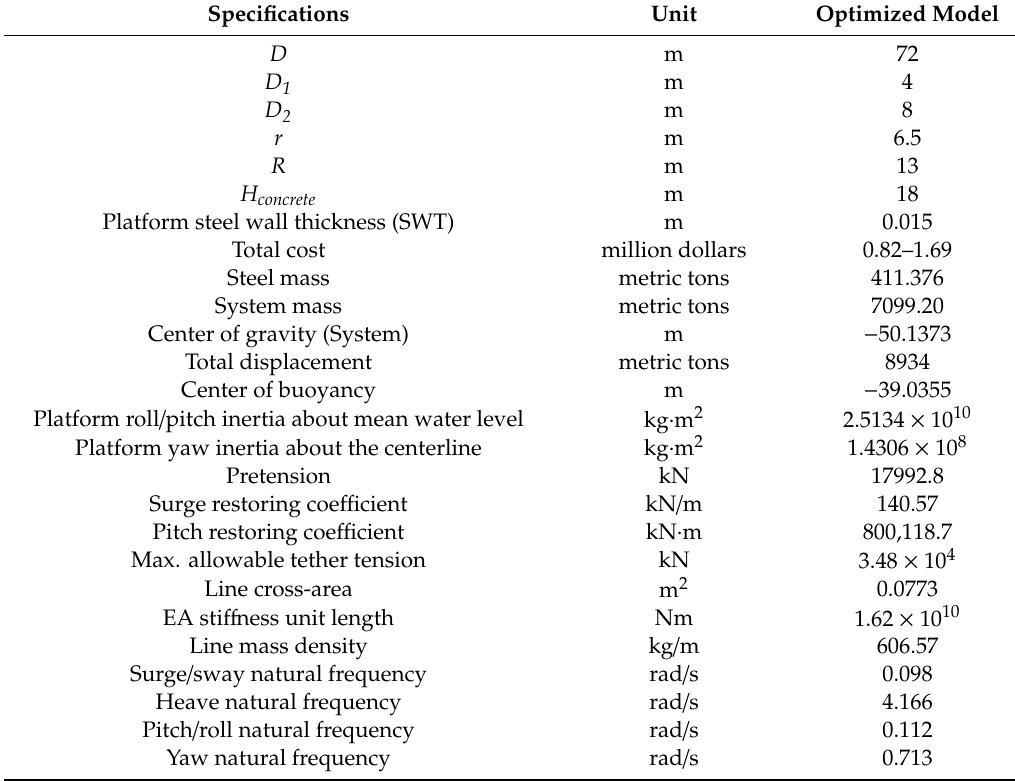
Table 9. Optimized SWAY model parameters (we define D, D 1 , D 2 r, R, H concrete in Figure